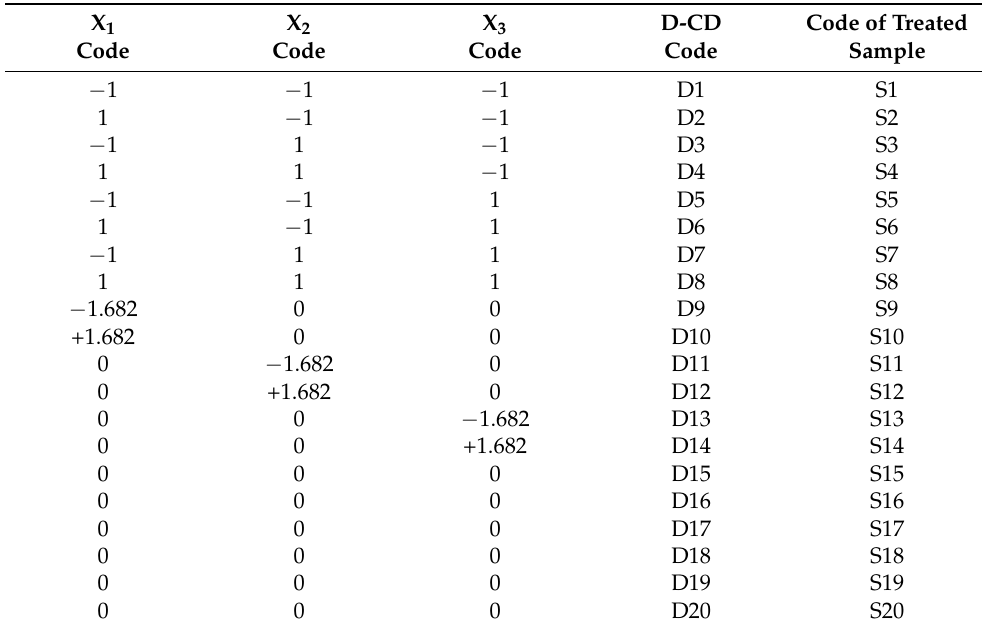
Table 2. Experimental